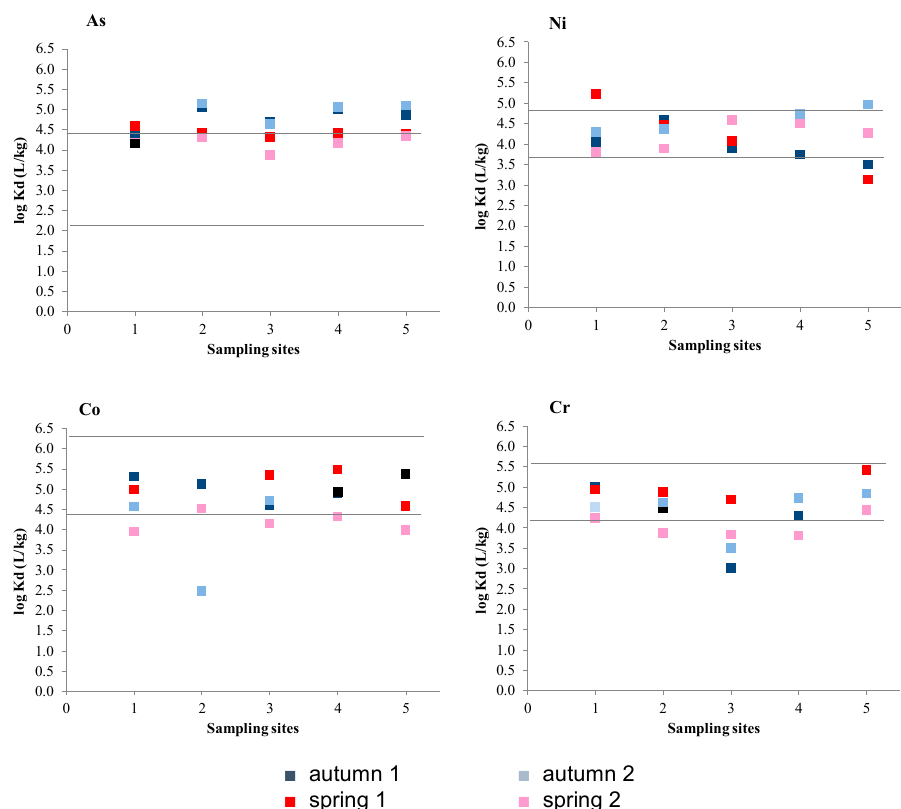
Figure 6. Values of log (K d (L/kg)) for the four elements in each sampling site and comparison with other ecosystems (solid lines corresponds to minimum and maximum values found in other ecosystems).